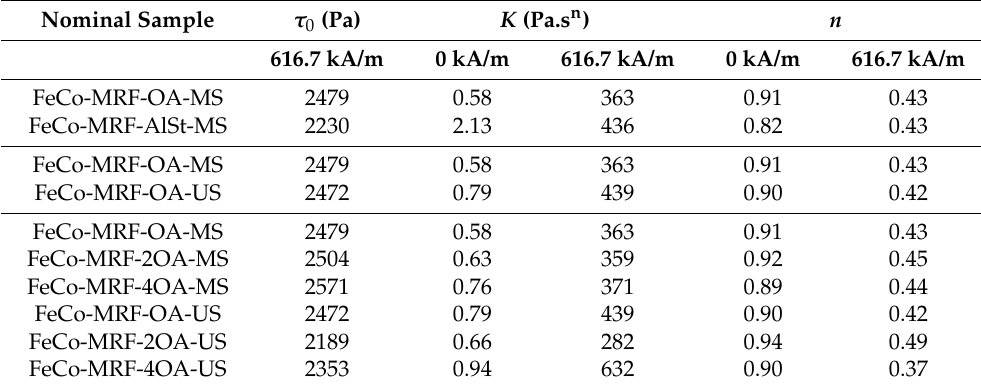
Table 3. Values of the stress measured at the maximum shear rate (600 s −1 ) under different applied magnetic field conditions, for the two different surfactants studied.